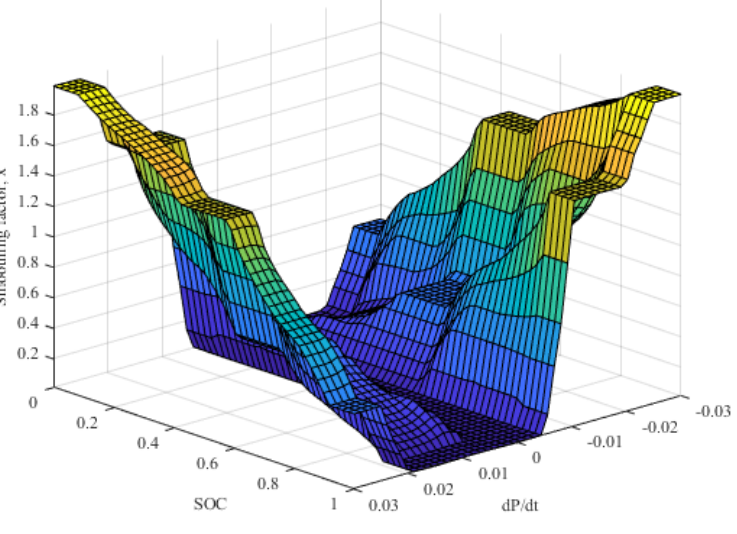
Figure 8. Input and output of the designed FLC.